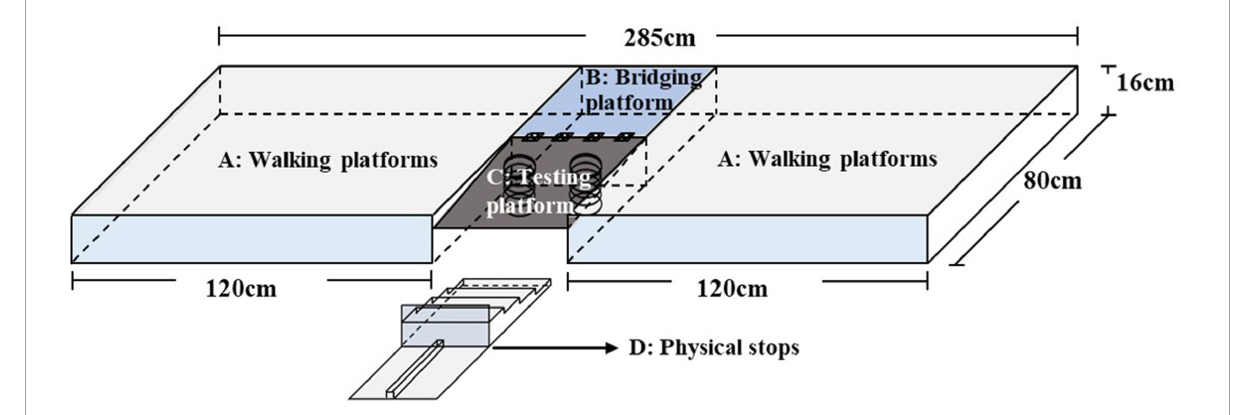
FIGURE1 Depicts the components of the Ankle Inversion Discrimination Apparatus–Walking (AIDAW). (A) : Walking platforms; (B) : bridging platform; (C) : testing platform; and (D) : physical stops.